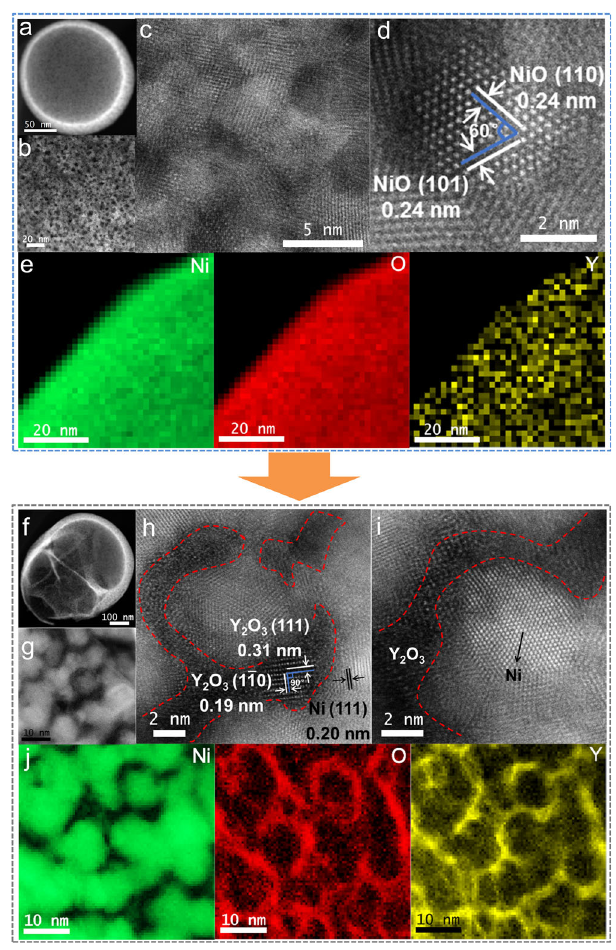
Fig. 2 The aberration-corrected HAADF-STEM images and elemental mappings. a − d Ni 9 Y 1 O x -fresh; f − i Ni 9 Y 1 O x -used; electron energy-loss spectroscopy (EELS) elemental mapping results of ( e ) Ni 9 Y 1 O x -fresh or ( j ) Ni 9 Y 1 O x 350 °C because NiO was not reduced below this temperature under reaction condition. In addition, the crystalline dominate size of metallic Ni increased gradually with the temperature rise (Supplementary Table 5), 5.5 nm at 400 °C and 9.6 nm at 500 °C, according to the calculation using Scherrer formula.